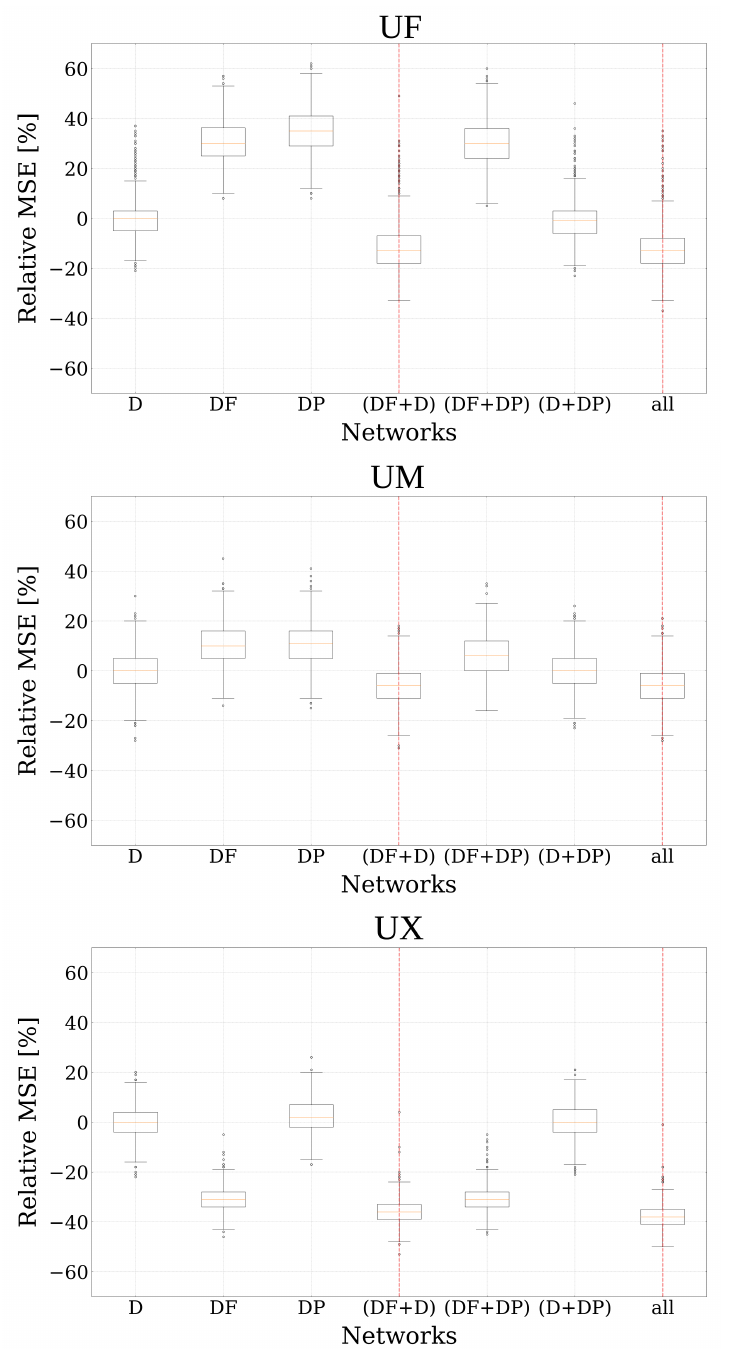
Figure 9. Boxplots represent the training MSE results of the algorithms with complexity (3, 2) using UF, UM, UX, and N = 20 samples. The x-axis represents the algorithm inputs we applied, and the y-axis denotes the relative MSE calculated, with D -input algorithms as a reference